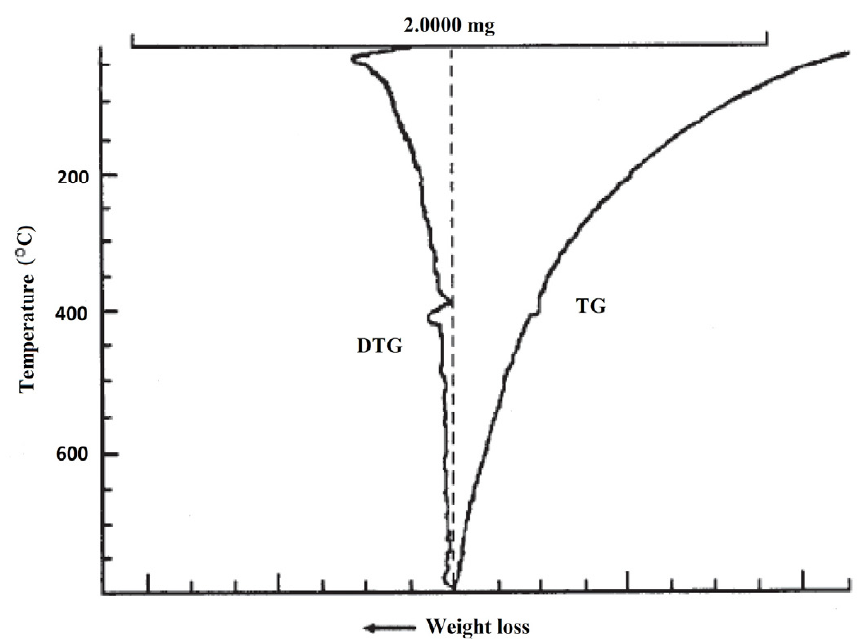
Fig. 4. DTG/TG spectrum of zeolite type of Fig. 4.